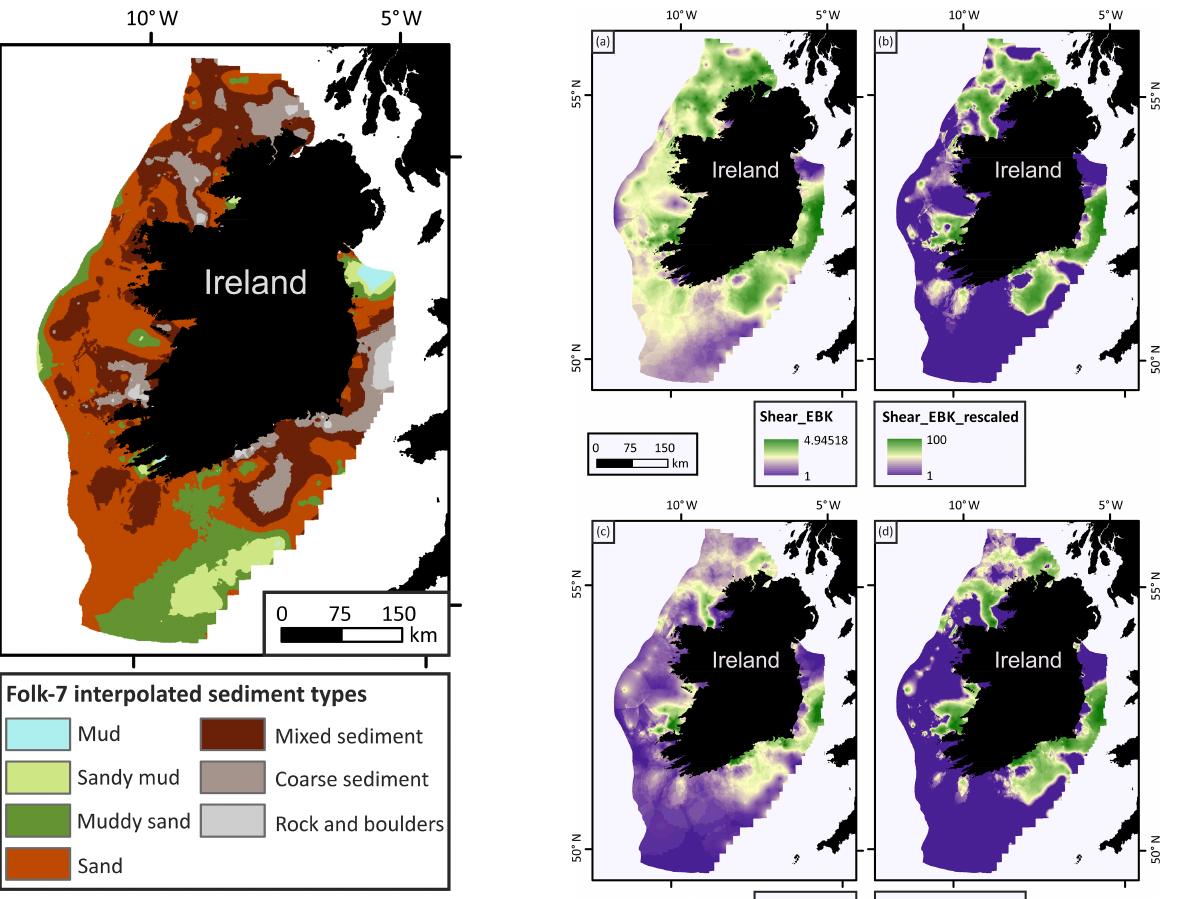
Figure 2. Map of interpolated values of the coded Folk-7 sediment categories (coded values in Table 1). Table 4. Area covered by each interpolated Folk-7 sediment type (as calculated in a GIS).